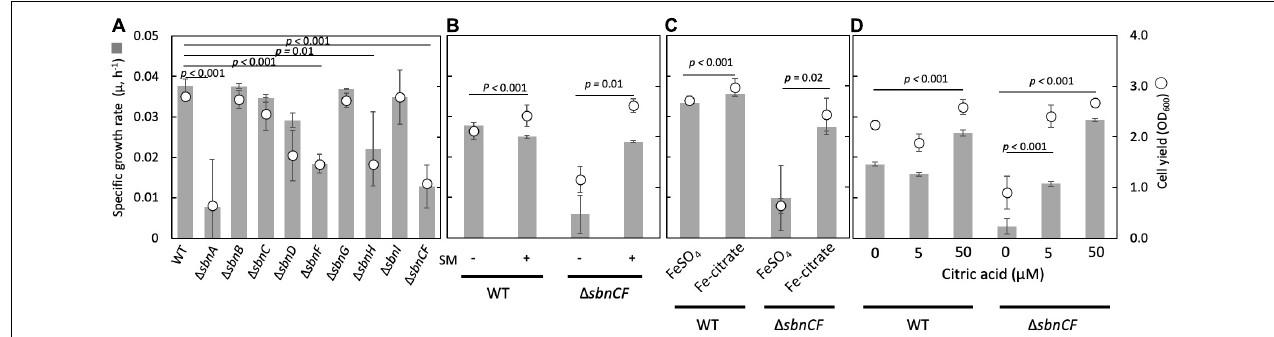
FIGURE 1 | (A) Growth of M. aquaticum strain 22A wild type (WT), siderophore sbn gene mutants on succinate with FeSO 4 . (B) Growth of WT and (cid:49) sbnCF on succinate with/without the addition of a spent medium (SM) of the WT. (C) Growth of WT and (cid:49) sbnCF on succinate in the presence of 100 µ M FeSO 4 or 100 µ M iron citrate. (D) Growth of WT and (cid:49) sbnCF on succinate in the presence of 50 µ M FeSO 4 and different concentrations of citrate. Bars, specific growth rate ( µ , h − 1 ); circles, cell yield (OD 600 ). All results are presented as the average ± standard deviation (SD) (biological triplicates).